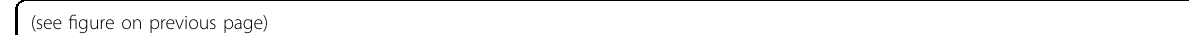
Fig. 1 Proteomic analysis of Omicron-induced host responses. a Distances of host responses of circulating proteomes in a principal component analysis (PCA) plot. The position of centroid colored in gray is the average value of the PC1 and PC2 coordinates of each sample in a patient group. The line connecting the centroid and each sample represents their distance. b 62 differentially expressed proteins between the Omicron and non- COVID-19 groups with fold change > 1.2 and Benjamini – Hochberg (B-H) adjusted P < 0.05, as shown in a heatmap. These proteins are enriched in three selected pathways by Ingenuity Pathway Analysis (IPA) ( P < 0.05). c – e Differential expression of GPT/ALT1 and GOT1/AST ( c ), CRP, SAA1 and SAA2 ( d ), CSK and GRB2 ( e ) across the fi ve patient groups. PrV, pre-vaccination; PoV, post-vaccination; OM, Omicron; NO, non-Omicron; RE, non- COVID-19 respiratory virus infection. * P < 0.05; ** P < 0.01; *** P < 0.001; **** P < 0.0001; ***** P <